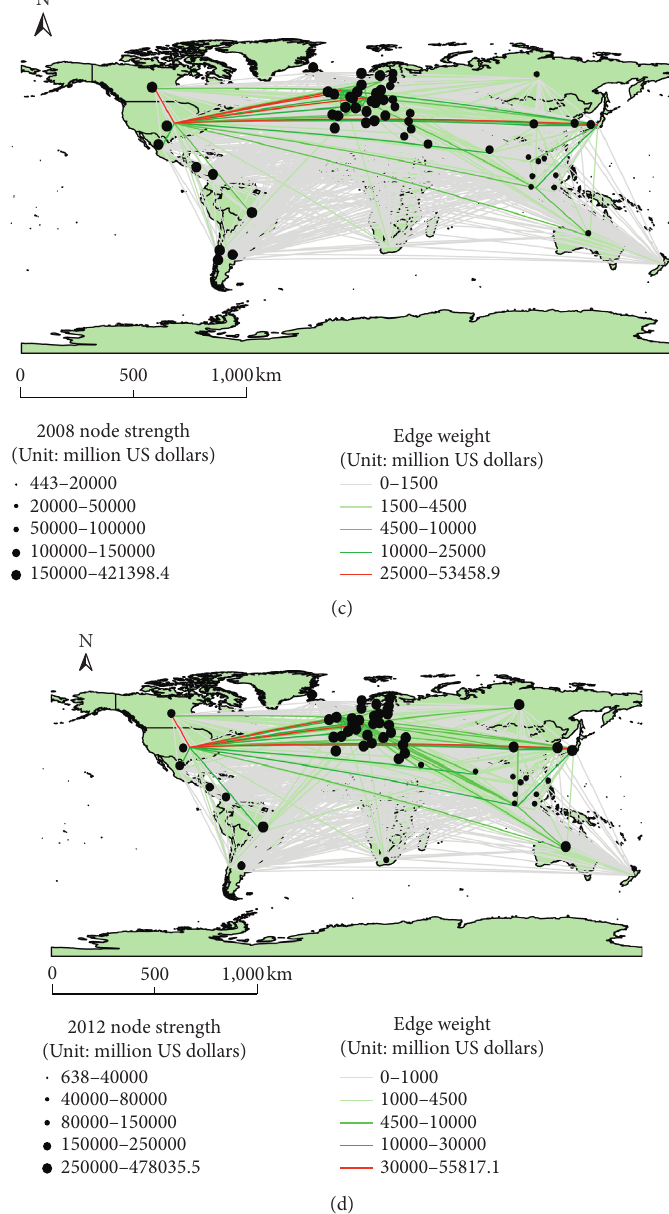
Figure 2: Spatial structure diagram of the producer services trade